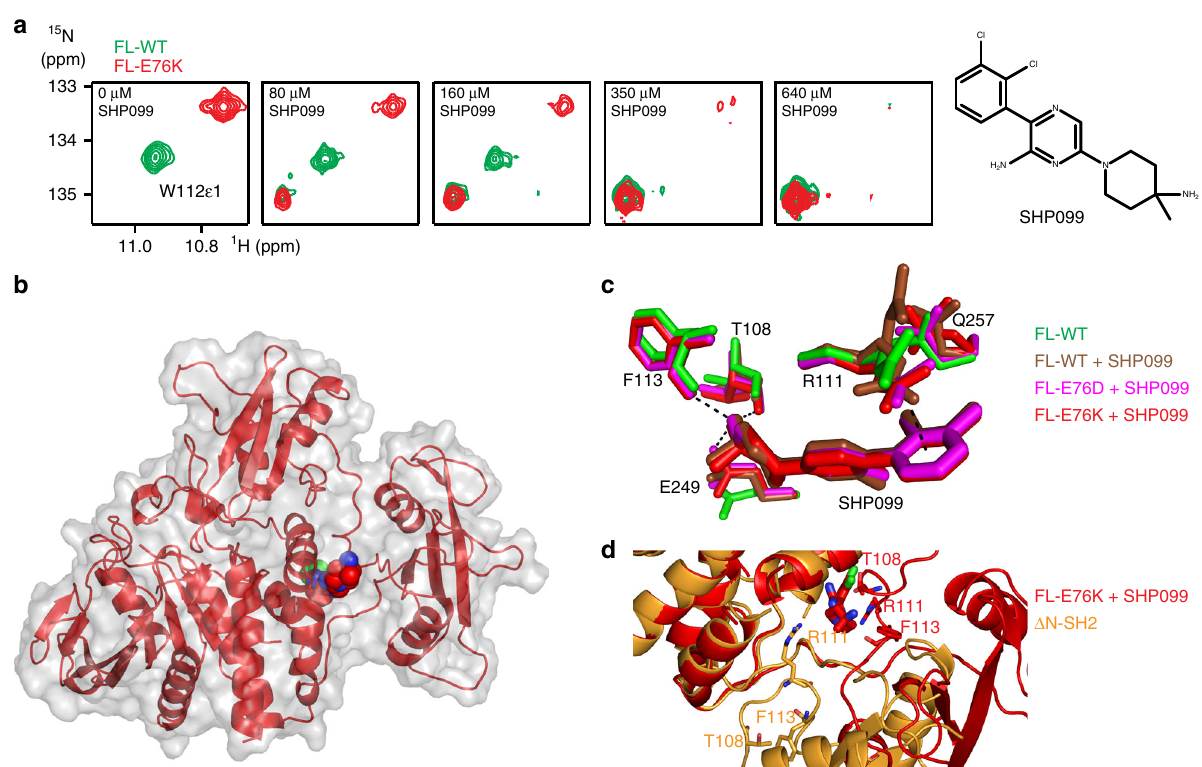
Fig. 4 NMR and crystallographic analyses of the binding of SHP099 to SHP2 variants. a Representative chemical shift changes of W112 ε 1 as seen for many residues away from the site of mutation upon binding of increasing amounts of SHP099 to 340 and 320 μ M FL-WT and FL-E76K, respectively. The chemical structure of SHP099 is shown on the right. b Surface representation of FL-E76K bound to SHP099 (in Van der Waals representation; PDB 6cms) reveals a closed SHP2 conformation very similar to FL-WT bound to SHP099 1 . c Superposition of the drug in the binding pocket of FL-WT and different mutant forms. The positions of residues important for SHP099 binding are already sampled in ligand-free structures of FL-WT (PDB 5i6v 17 ). d Superposition of the Δ N-SH2 structure (orange, PDB 6cmp) with FL-E76K bound to SHP099 (red, PDB 6cms), using the PTP domain as reference. The rotation of the C-SH2 in the open conformation (orange) displaces residues T108, R111, and F113 from the SHP099 binding